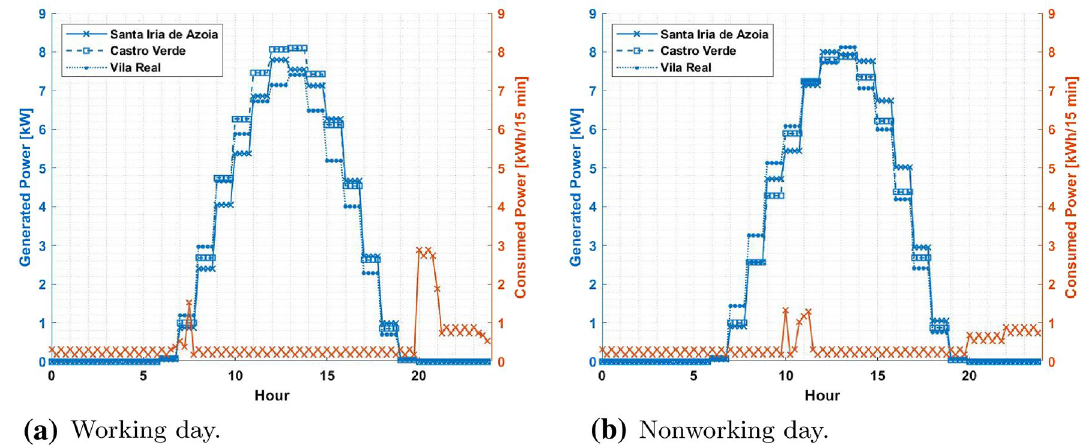
Fig. 16 Generation and consumption curves on the two significant days of August for c-Si NWs technology